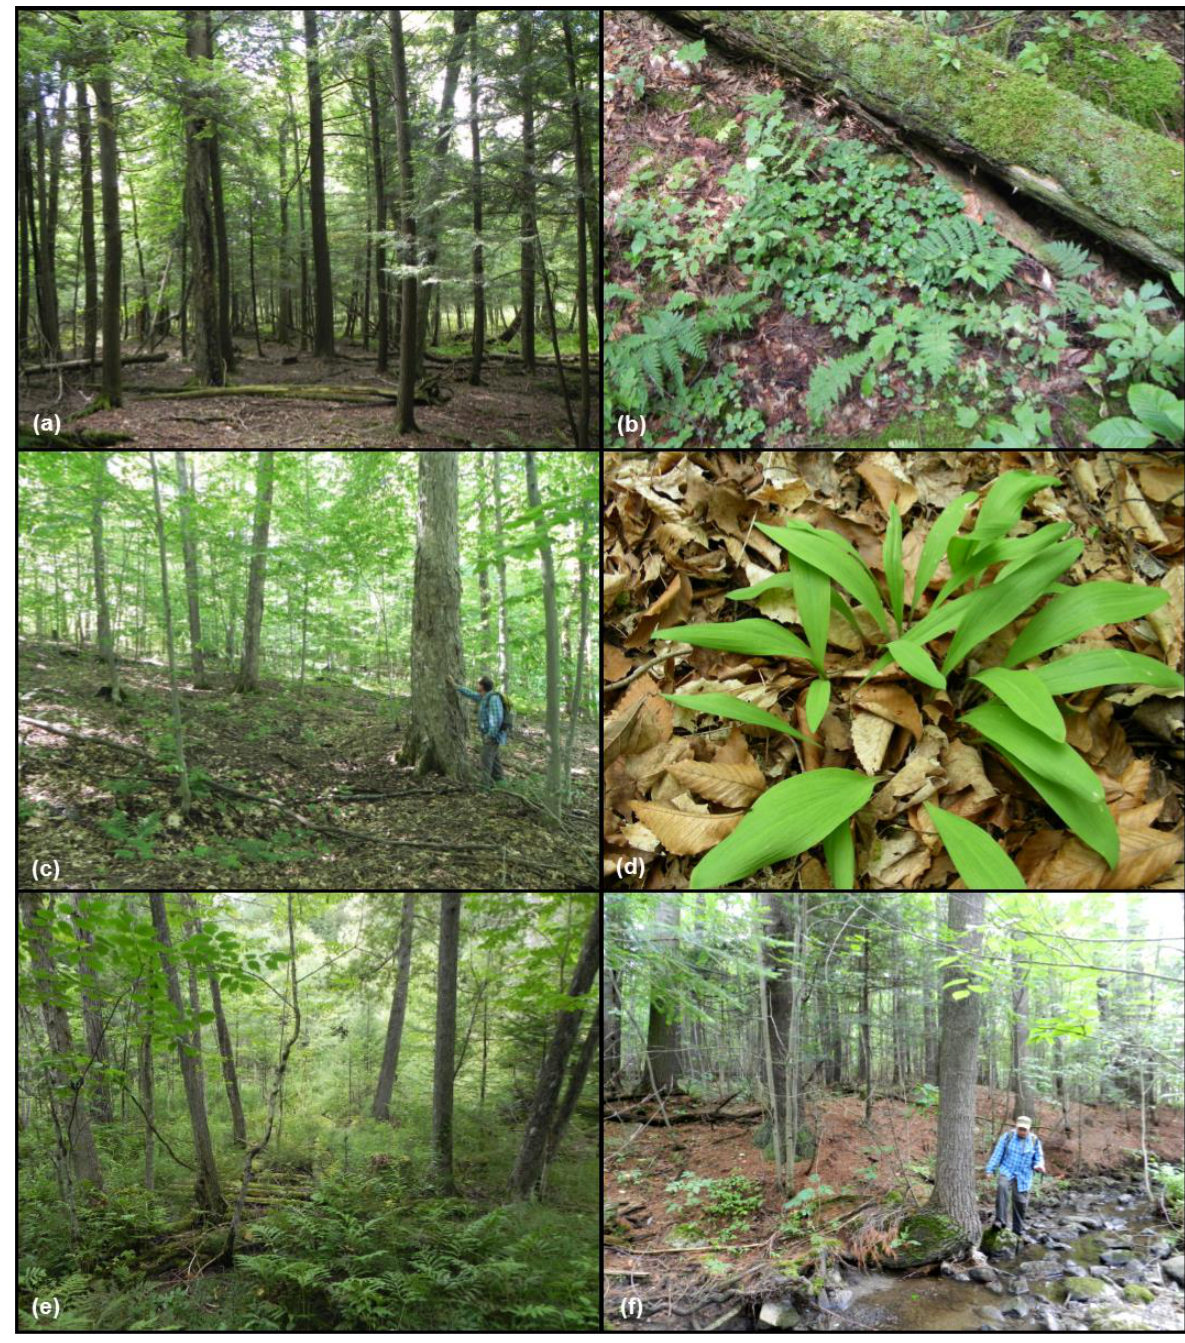
Figure 5. Conservation zone: ( a ) Old-growth stand (255 years) of the hemlock—sugar maple—yellow birch community type (O-4); ( b ) Deadwood in old growth hemlock stand (O-4), showing fungi, lichens, bryophytes and tree seedlings, with several more species of bryophytes and vascular plants on the forest floor; ( c ) Sugar maple—white ash stand (O-1) with a large sugar maple legacy tree; ( d ) Wild leek ( Allium tricoccum ), a legally protected species, in rich sugar maple—white ash stands; ( e ) Degraded white cedar swamp stand (O-6), with small cedar trees and signs of partial harvesting; ( f ) White pine stand (Y-5), along the edge of the easternmost stream, near the shore of Lake